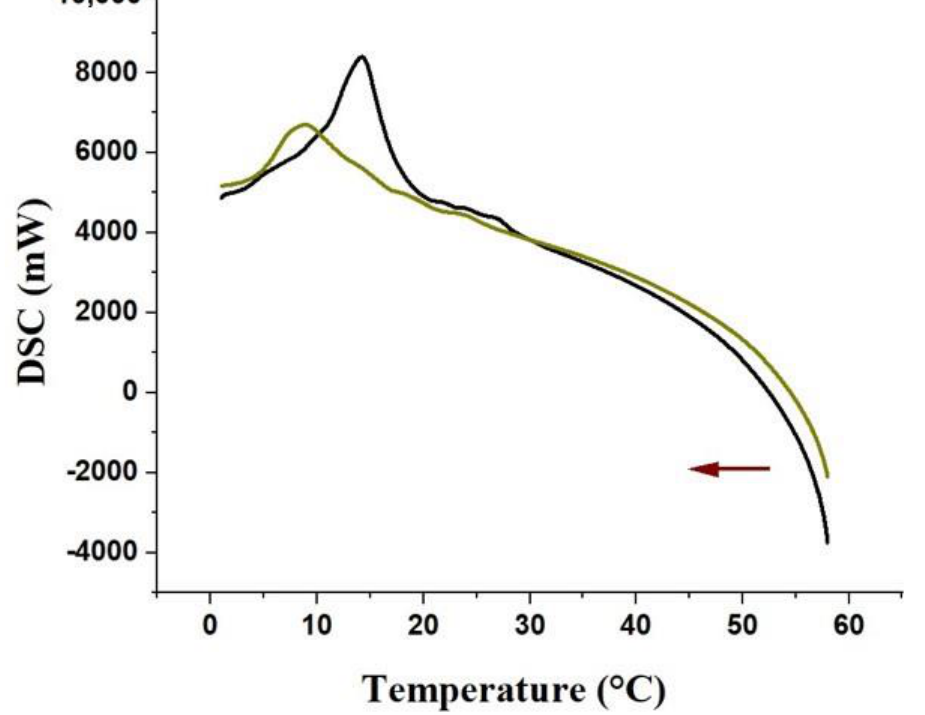
Figure 5. The heat flux graph during cooling versus temperature (60 – 0 °C; red arrow) of the VADE- loaded-hydrogel (green curve) and hydrogel without VADE (black curve).